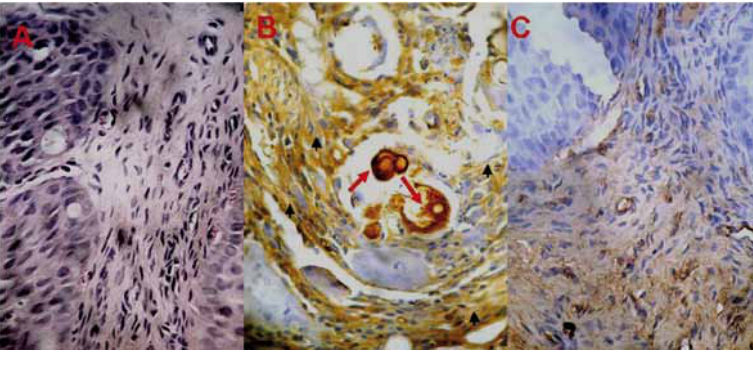
Figure 4 - vEGF expression in grafted and non grafted areas over the time. (A) - non grafted area. (B) – grafted area 15 days after surgery: higher vEGF expression (black arrows) and remaining latex membrane (red arrows). (c) – grafted area 90 days after surgery: note the reduction of vEGF expression. (400x).